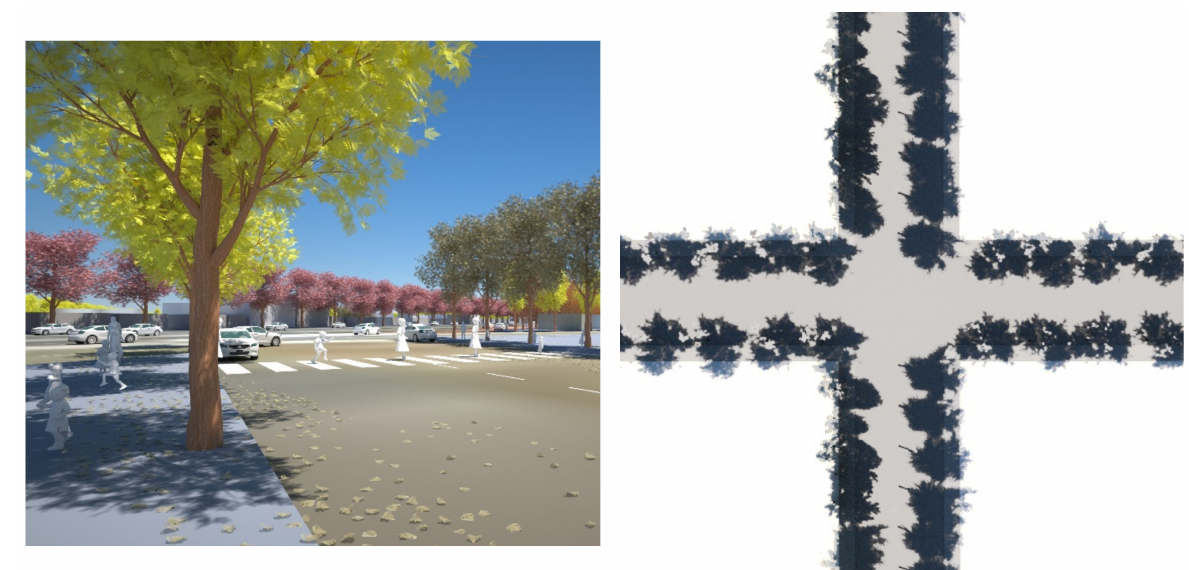
Figure 3. Image showing visual aesthetic assessment with high-definition streetscape rendered visualisation LEFT and texture baked shade assessment output RIGHT. Image by authors using multi-criteria street design decision support modelling approach in Autodesk™ 3ds